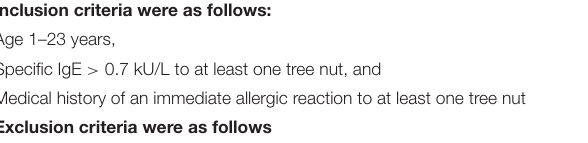
TABLE 1 | Inclusion and exclusion